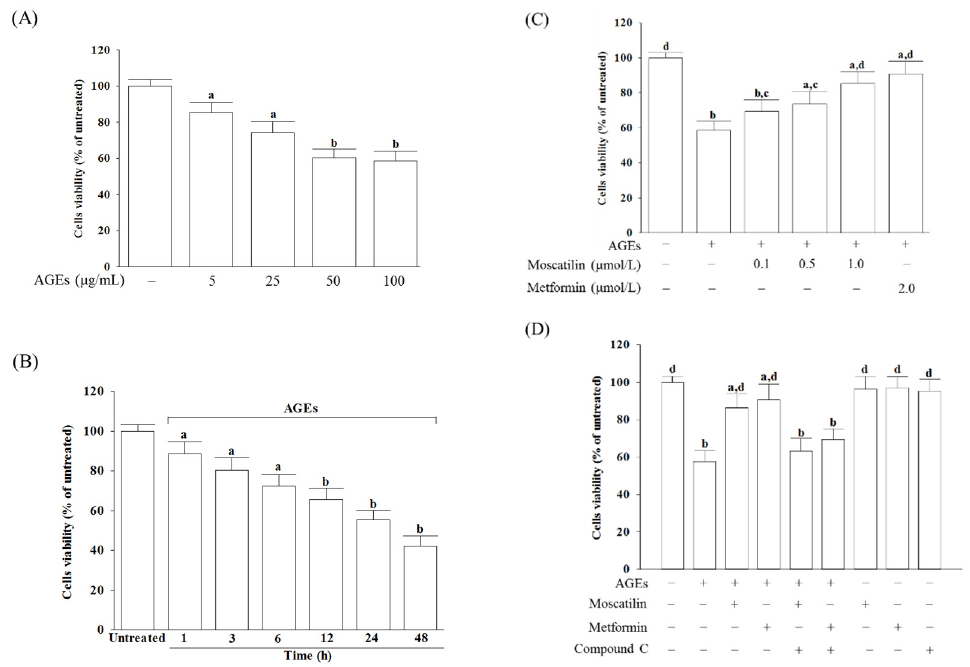
Figure 1. Influences on the decreased cell viability in advanced glycation end-products (AGEs)-treated SH-SY5Y cells. ( A ) SH-SY5Y cells were incubated with various concentrations of AGEs for 24 h. ( B ) SH-SY5Y cells were incubated with 50 µ g / mL AGEs for various timepoints. ( C ) SH-SY5Y cells were pretreated with different concentrations of moscatilin (0.1, 0.5 or 1 μ mol/L) or metformin (2 µ mol / L) for 1 h, followed by exposure to 50 µ g / mL AGEs for another 24 h. ( D ) Compound C (5 µ mol / L) was added 1 h before moscatilin (1 µ mol / L) or metformin (2 µ mol / L) were stimulated. Cell viability was determined using an MTT assay and expressed as a percentage of the untreated cells. The results are presented as the mean ± SD of five independent experiments ( n = 5), each of which was performed in triplicate. a p < 0.05 and b p < 0.01 compared to the data from untreated group (vehicle control). c p < 0.05 and d p < 0.01 when compared to the data from cells cultured under AGEs without any treatment.